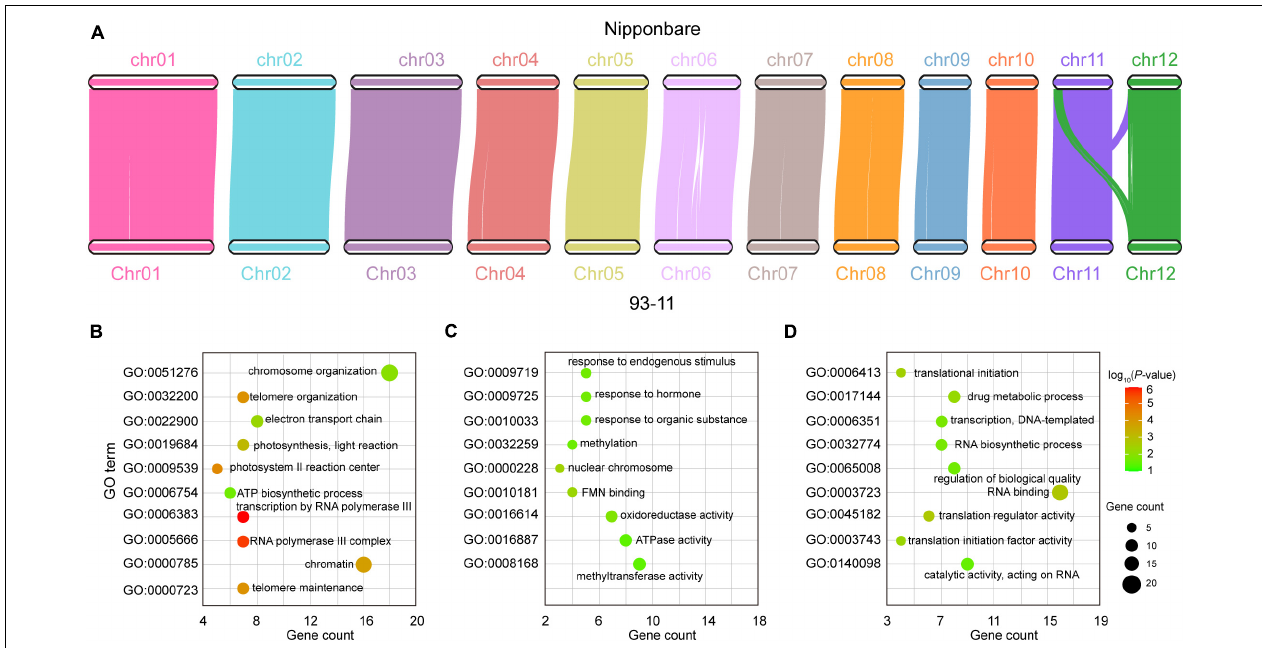
FIGURE 2 | Comparative genomic analysis of 93-11 and Nipponbare. (A) Collinearity between the 93-11 and Nipponbare genomes. There are 27,729 homologous genes in the collinear regions, indicating that the two genomes have a high degree of collinearity. (B) Gene ontology (GO) enrichment of the genes in non-syntenic regions. (C) GO enrichment of the rapidly evolving genes in the 93-11 genome. (D) GO enrichment of the rapidly evolving genes in the Nipponbare genome. These results indicate the species specificity of gene evolution after species differentiation. The color scale indicates the P- value, and the size of the circle indicates the number of